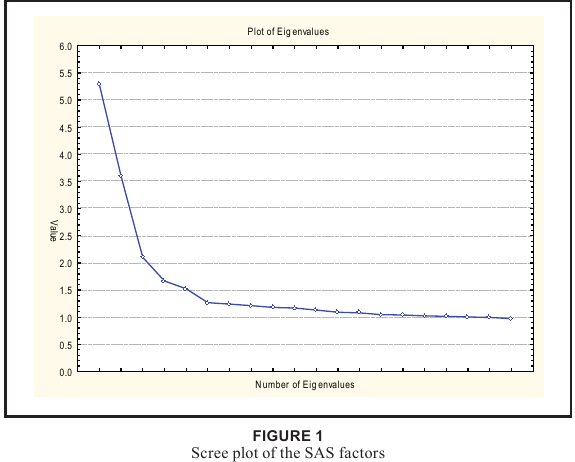
Figure 1 Scree plot of the SAS